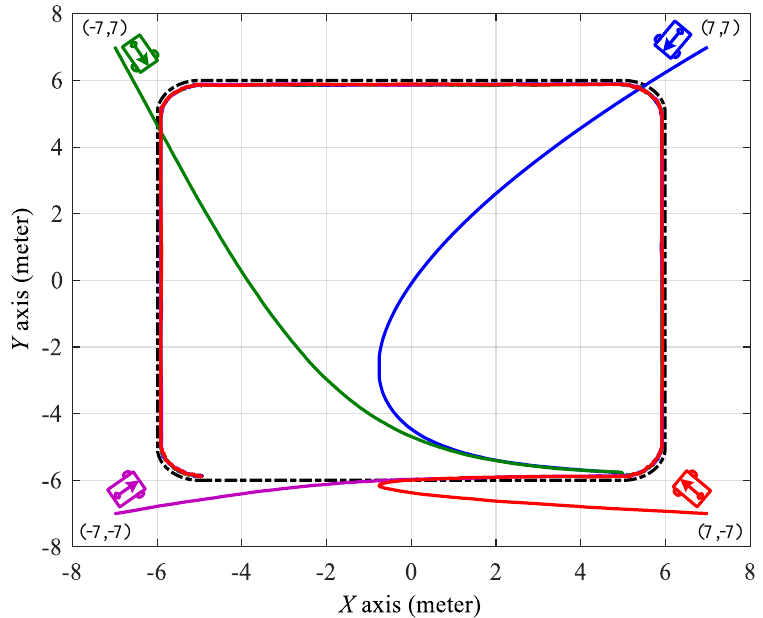
Figure 4. The verification result of the square trajectory by the H 2 closed-form control approach from x p = 7 m, y p = 7 m (blue line), x p = − 7 m, y p = 7 m (green line), x p = − 7 m, y p = − 7 m (purple line), x p = 7 m, y p = − 7 m (red line).